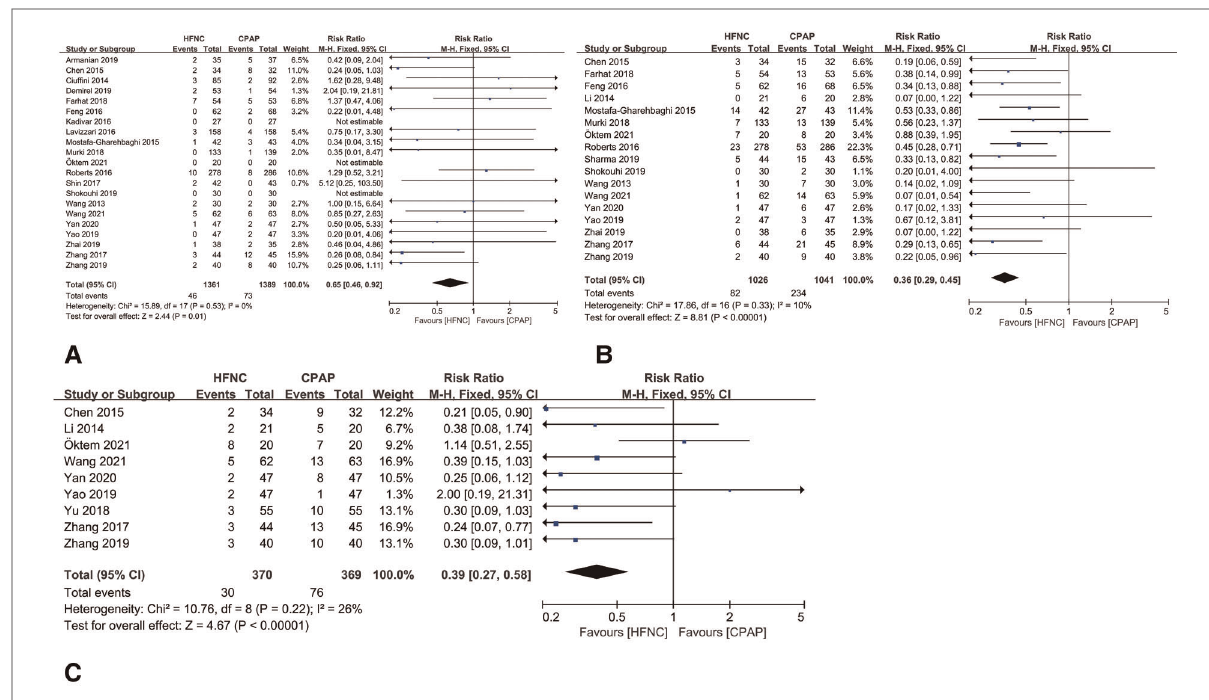
FIGURE 6 ( A ) forest plot of comparison: HFNC vs. CPAP-number-Air leaks. ( B ) Forest plot of comparison: HFNC vs. CPAP-number-Nasal trauma. ( C ) Forest plot of comparison: HFNC vs. CPAP-number-Abdominal